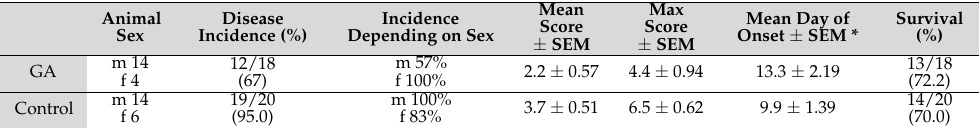
Table 1. OSE incidence and treatment-related scores.